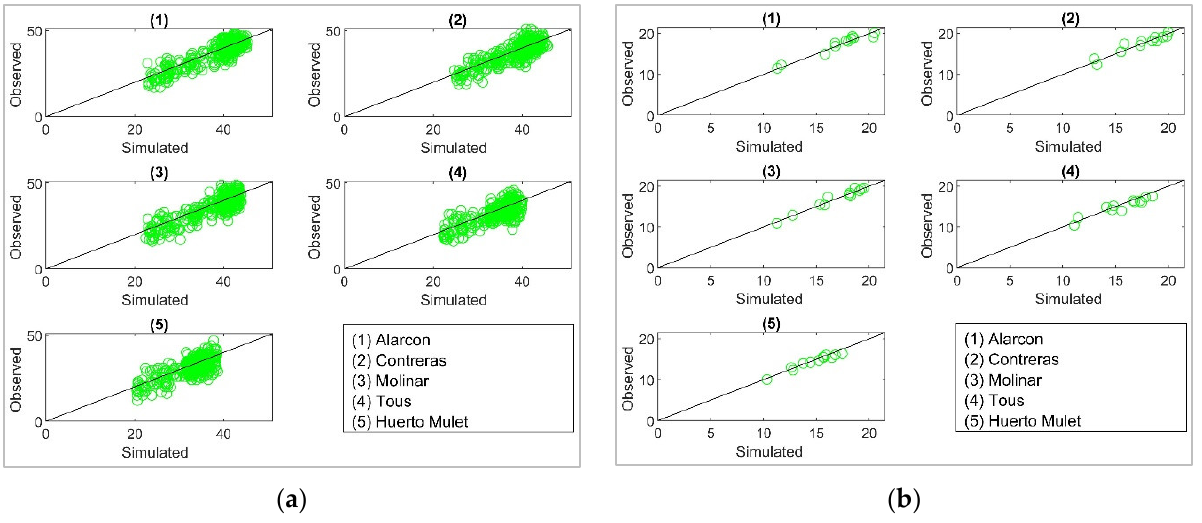
Figure 8. Scatter plots for rainfall occurrence (mean 66 years observed and 1000 simulated series) for the five sub-basins: ( a ) daily mean for each calendar day (green) and ( b ) monthly mean for each calendar moth (green) for M1 and M2.